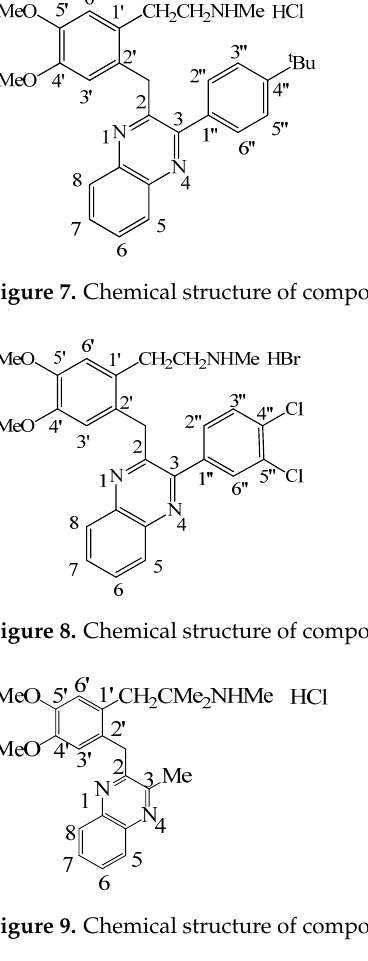
Figure 10. Chemical structure of compound 2g . Figure 11. Chemical structure of compound 4b . 4.1.1. 2 ‐ (2 ‐ {[3 ‐ (4 ‐ (Tert ‐ butyl)phenyl]quinoxalin ‐ 2 ‐ yl]methyl} ‐ 4,5 ‐ dimethoxyphenyl) ‐ N ‐ methyle thanamine hydrochloride ( 2b ) The